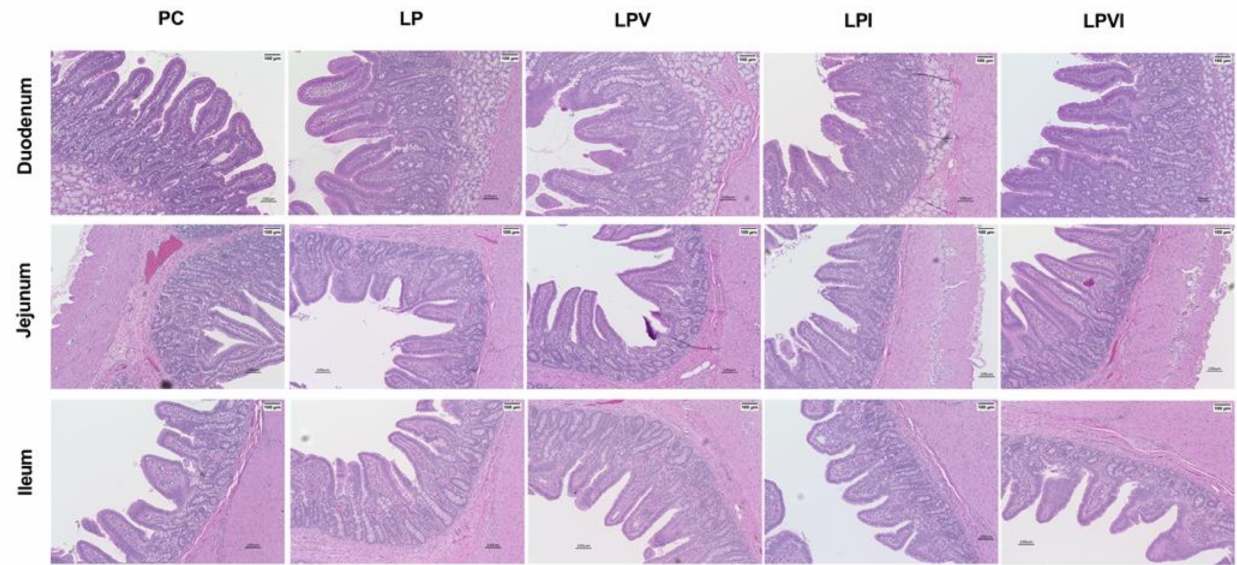
Figure 4. Representative intestinal hematoxylin and eosin-stained sections ( × 10 magnification) micrographs of duodenum, jejunum, and ileum in pigs fed with very-low-protein diets supplemented with Ile, Val, or combination of both. PC (positive control): standard-protein diet; LP (negative control): low-protein diet containing limiting amino acids (i.e., Lys, Met, Thr and Trp) at NRC (2012) levels; LPV: LP containing Val at NRC level; LPI: LP containing Ile at NRC level; LPVI: LP containing Val and Ile at NRC levels. n =